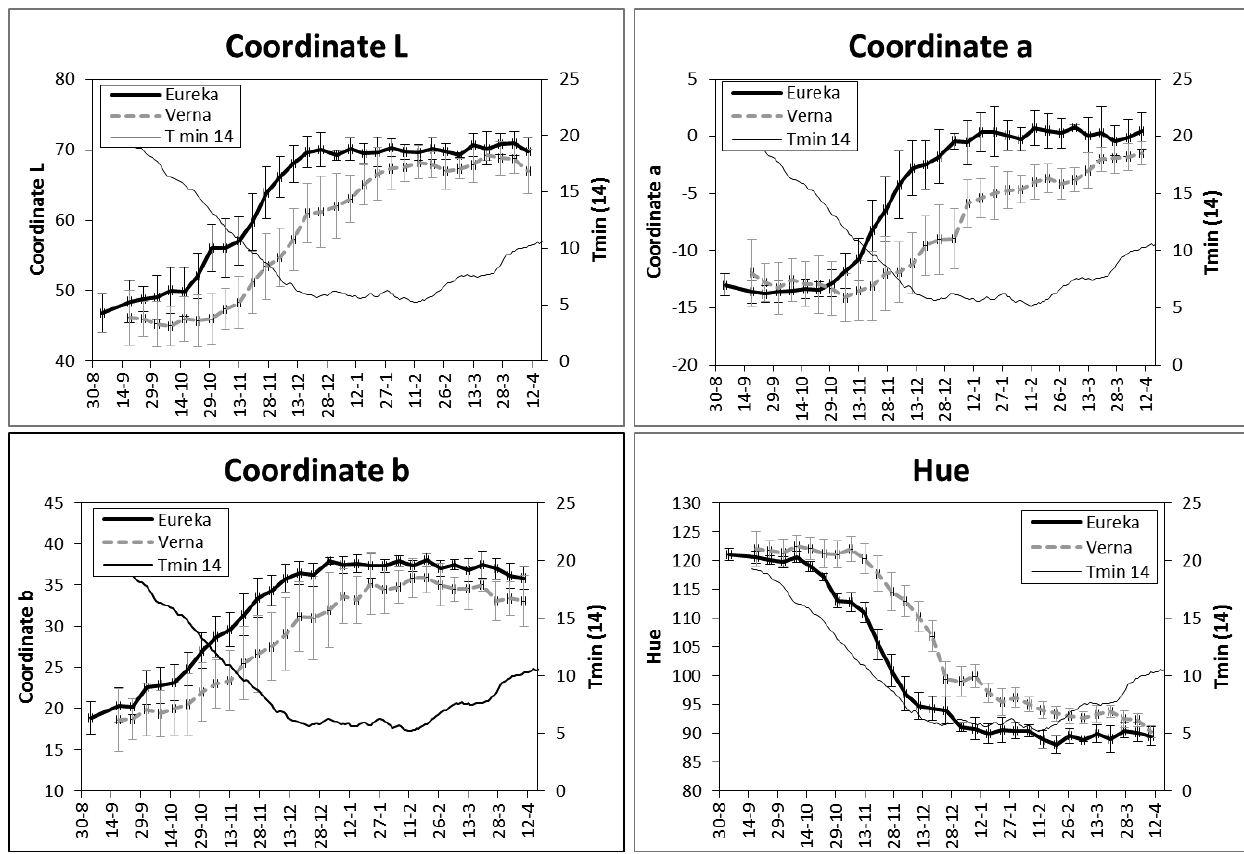
Fig. 5: Evolution of colour coordinates L , a and b , hue angle and mean minimum temperatures (and standard deviation) for the 14 preceding days in Eureka and Verna cultivars. Values are the means of all the growing seasons